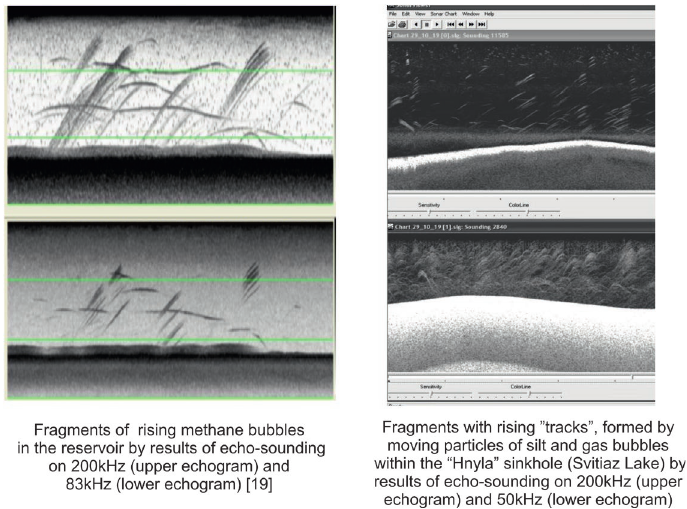
Fig. 6. Comparative fragments of